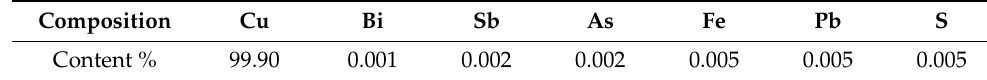
Table 2. The composition of the pure copper.